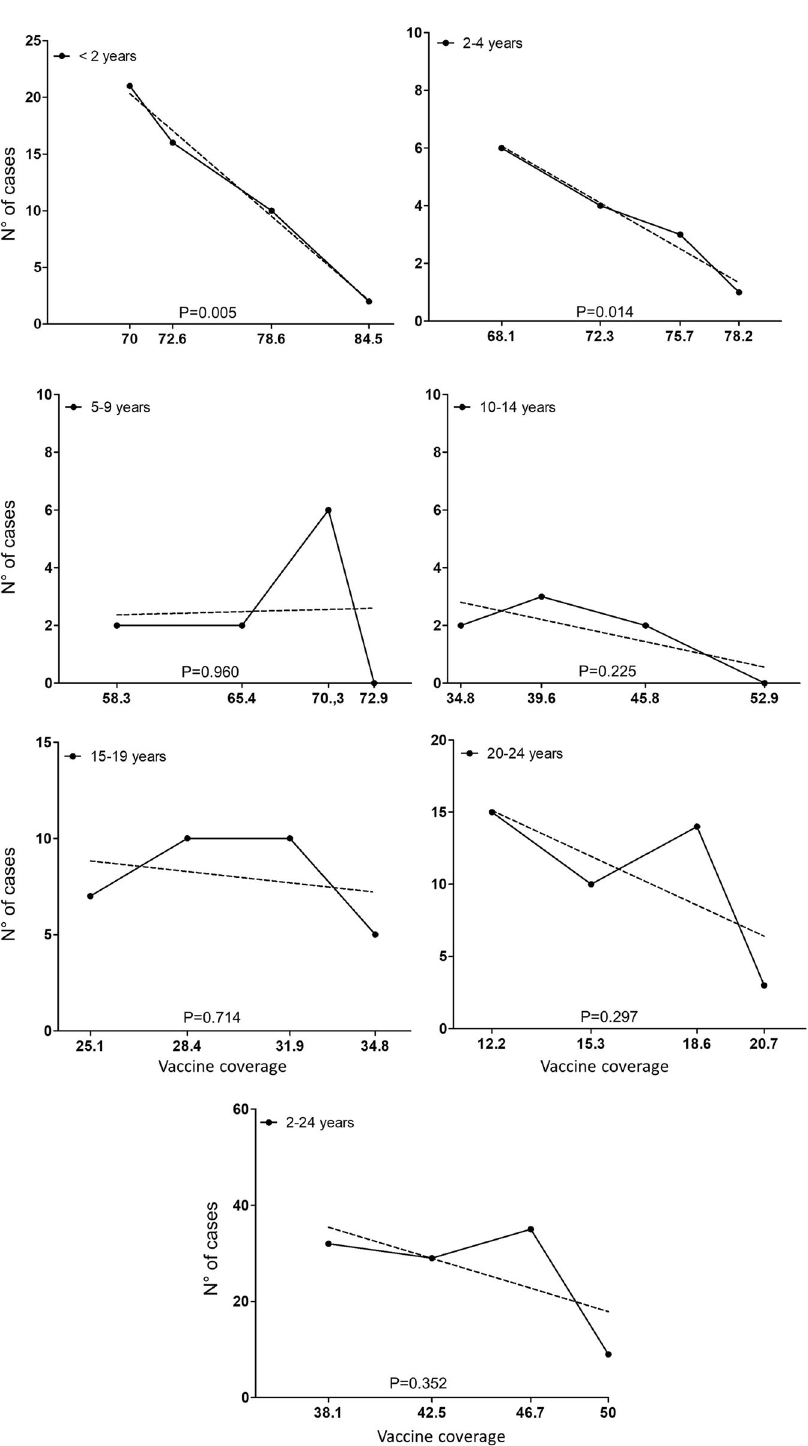
Fig. 4 Evolution of number of cases of IMD due to serogroup C per age group according to vaccine coverage. Age groups are indicated. The number of cases is indicated on the vertical axis. The horizontal axis represents the coverage rate (in percentage) per year from 2016 (fat left) to 2019 (far right) and linear regression (dashed lines). P values for a slope different from zero are